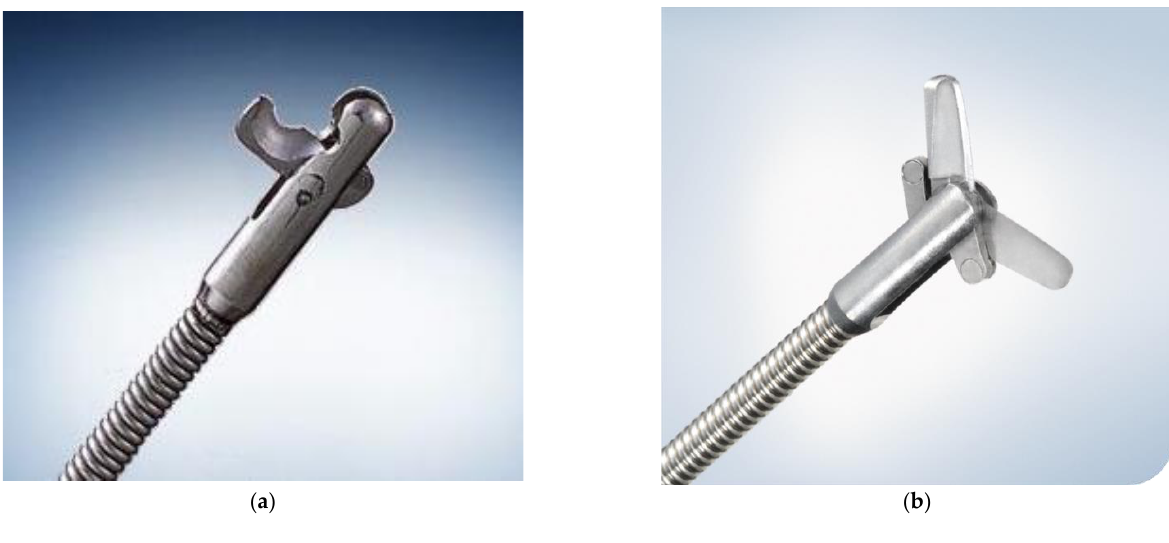
Figure 1. Cutting devices. ( a ) Loop cutter. ( b ) Surgical scissors.